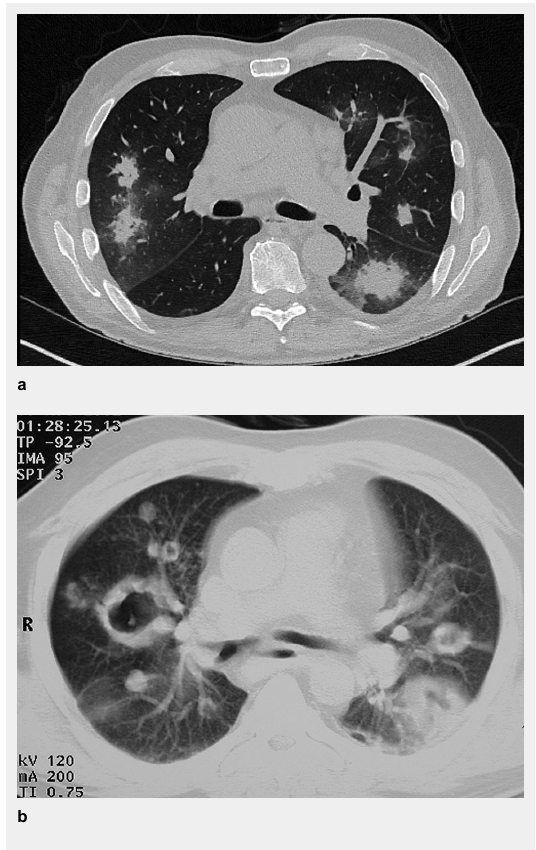
Computed tomography images of invasive pulmonary aspergillosis. a) Neutropenic patient, early stages: sharply demarcated nodes and dense lesions surrounded by a ground-glass halo. b) Rheumatology patient on corticosteroid treatment, early stages: centrally cavitating dense